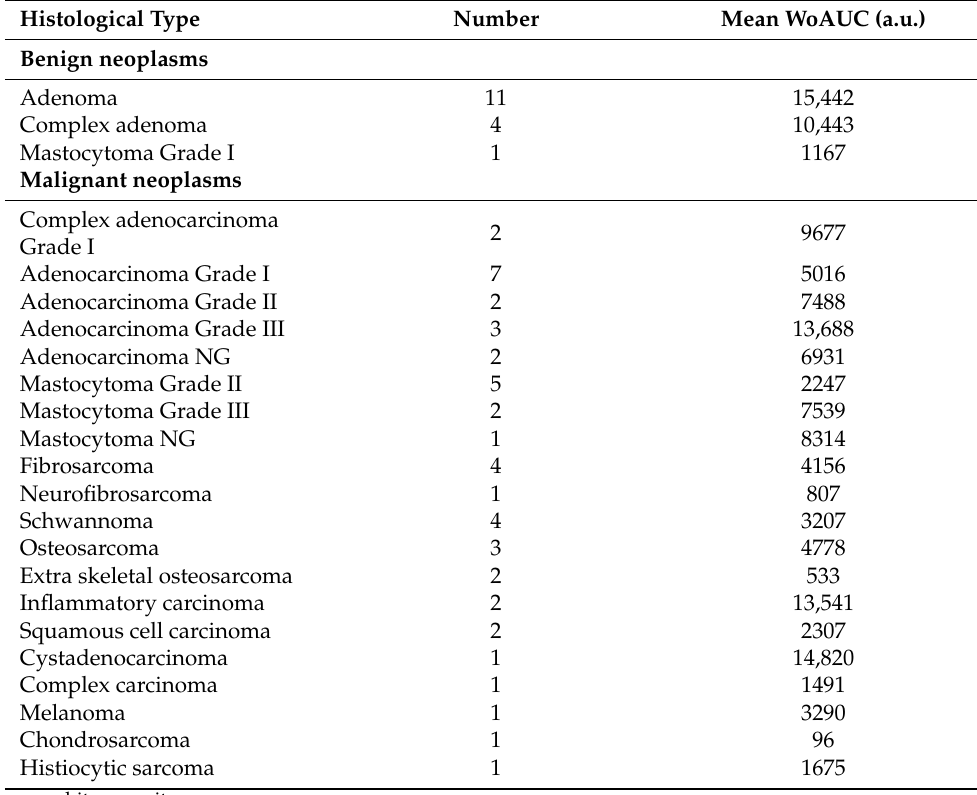
Table A1. A summary of the mean wash-out area under the curve (WoAUC) at the center of the neoplasm according to histological